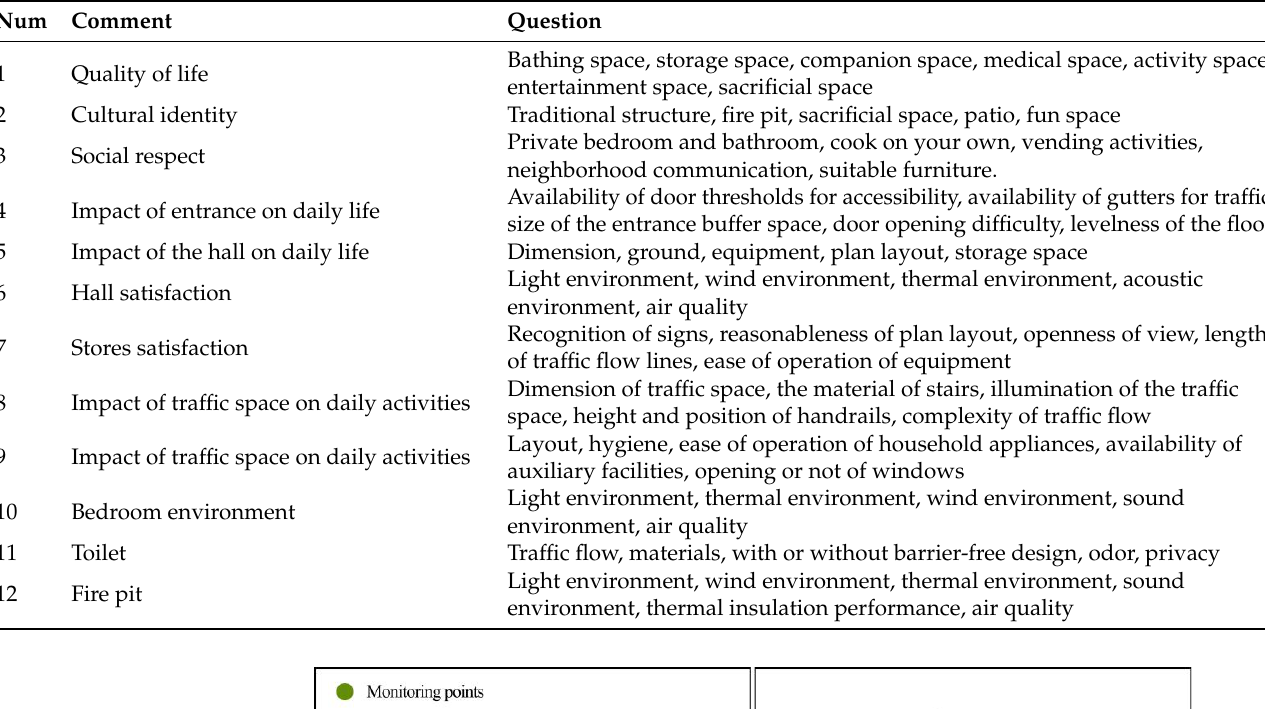
Table 3. Questionnaire surveys the content of the elderly in ancient towns.